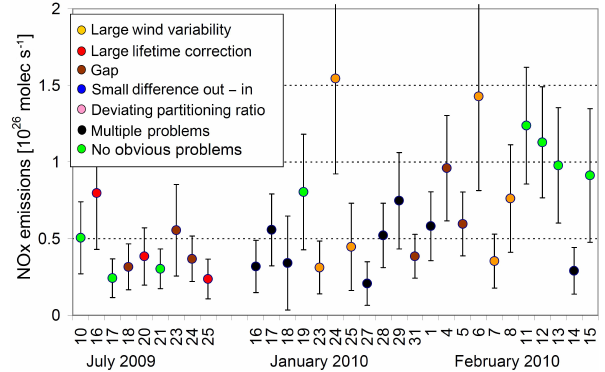
Figure 16. NO x Emissions derived from the car MAX-DOAS mea- surements (using individual partitioning ratios and scaled to daily average values). The colours of the data points indicate different error sources (see also Table 3).